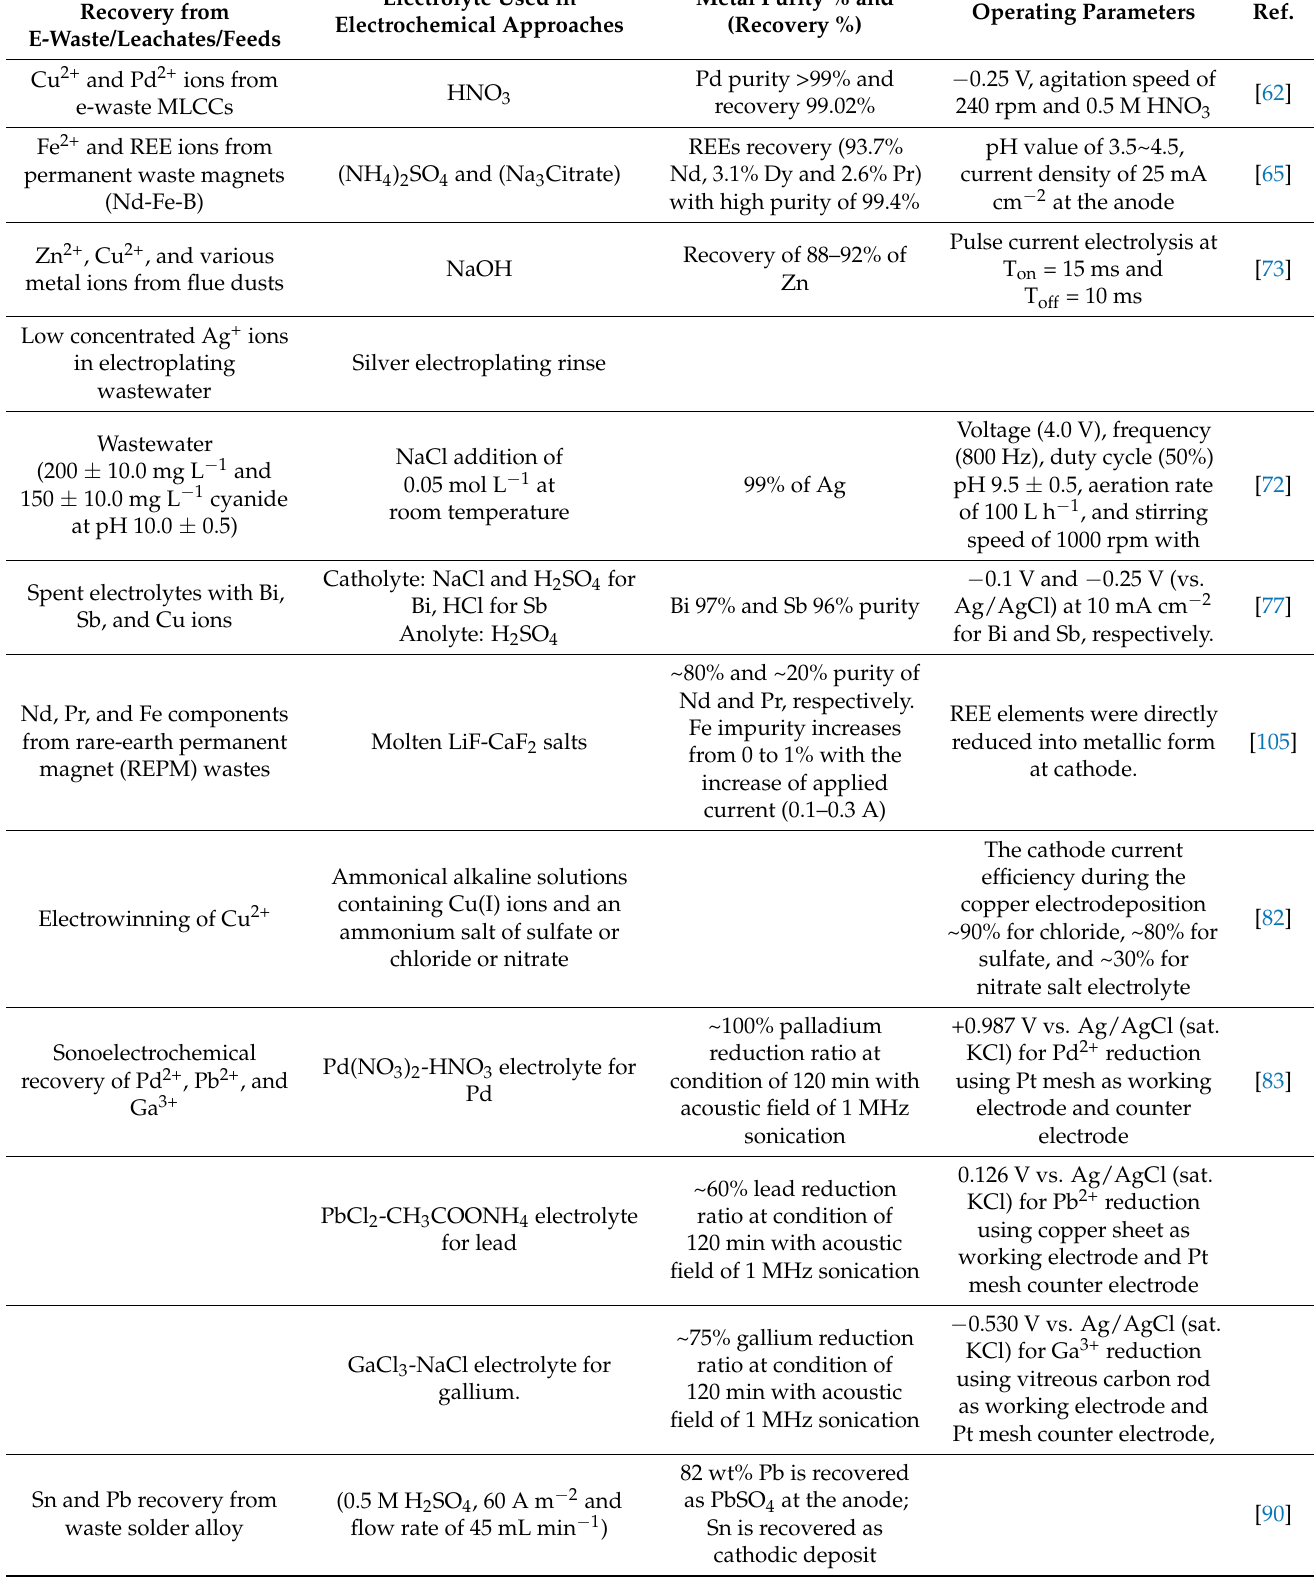
Table 3. Summary of metal recovery from e-waste using electrochemical approaches, electrodeposition, and electrowinning. Target Metals